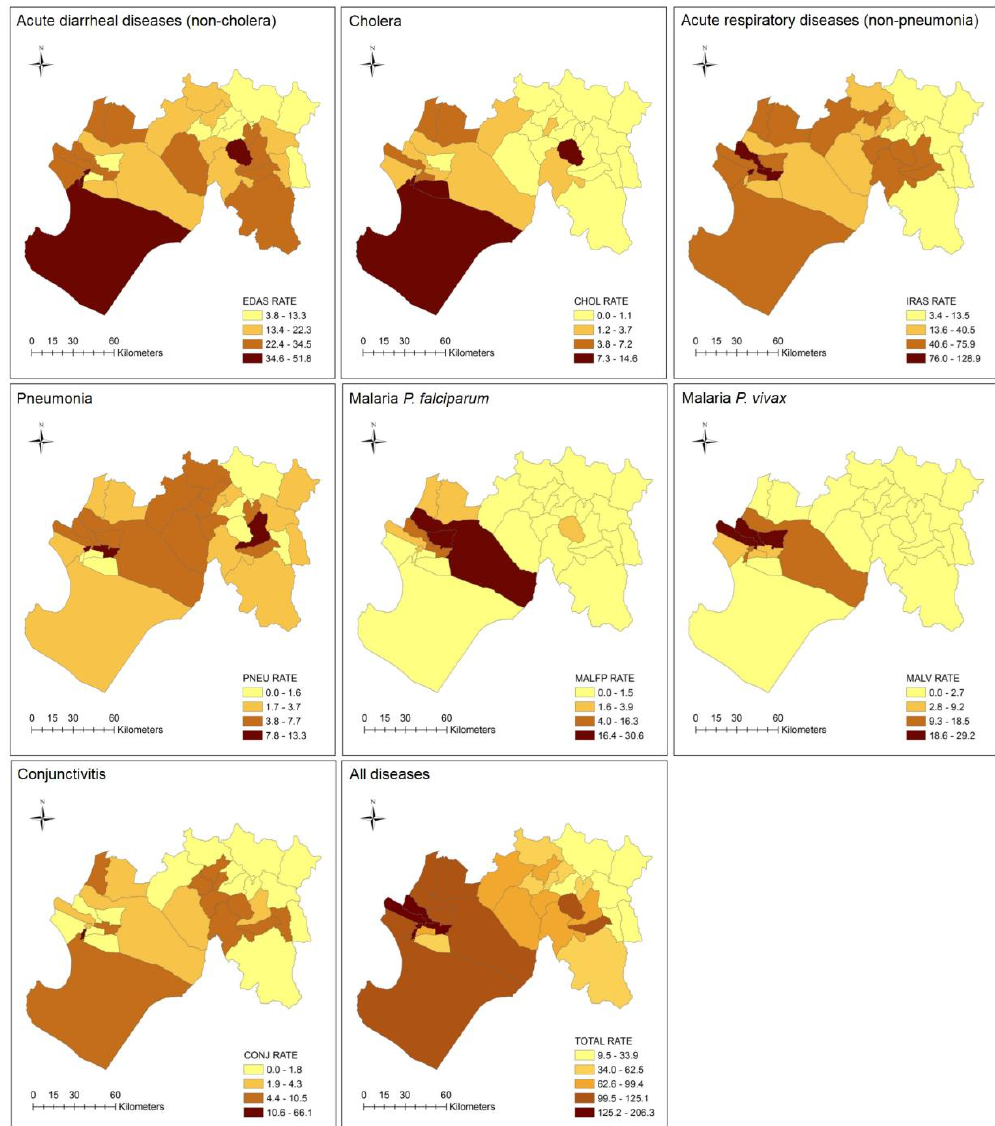
Figure 4. Maps of disease incidence rates (per 1000) at the district-level for the entire season, natural breaks classification: EDAS (acute diarrheal diseases—non-cholera); cholera; IRAS (acute respiratory diseases—non-pneumonia); pneumonia; malaria P. falciparum ; malaria P. vivax ; conjunctivitis; and total (all